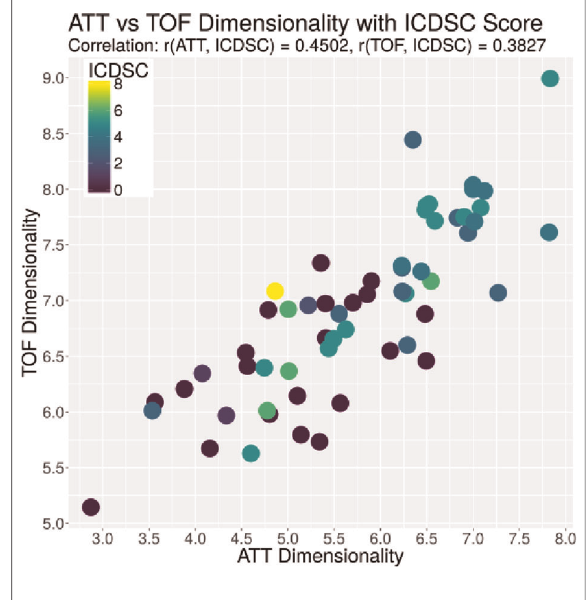
FIGURE 4 Plot of the dimensionality of the ATT vs. the dimensionality of the TOF. Every dot represents one patient on day 1; the color represents the ICDSC score of that patient on that day.